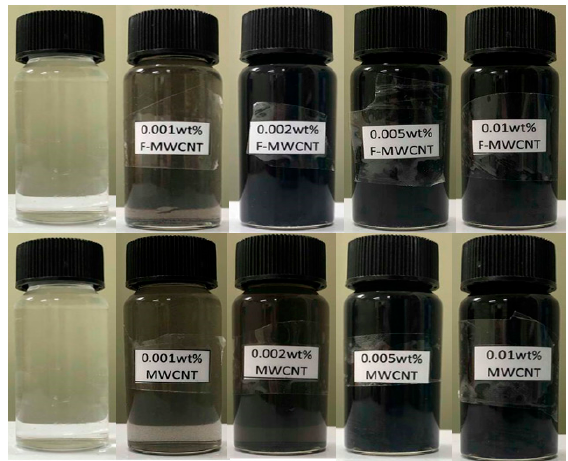
Figure 1. Pictures of 0.001, 0.002, 0.005 and 0.01 wt% functionalized and nonfunctionalized MWCNT nanofluid.